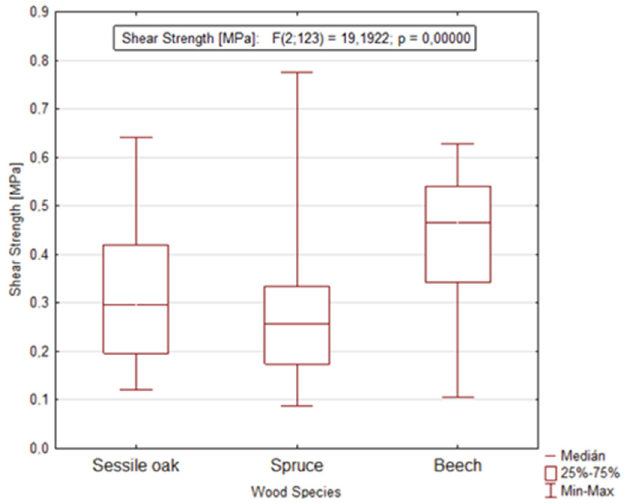
Figure 7. Graph showing the dependence of shear strength on the wood species during dormant and growing season in the longitudinal and tangential direction.